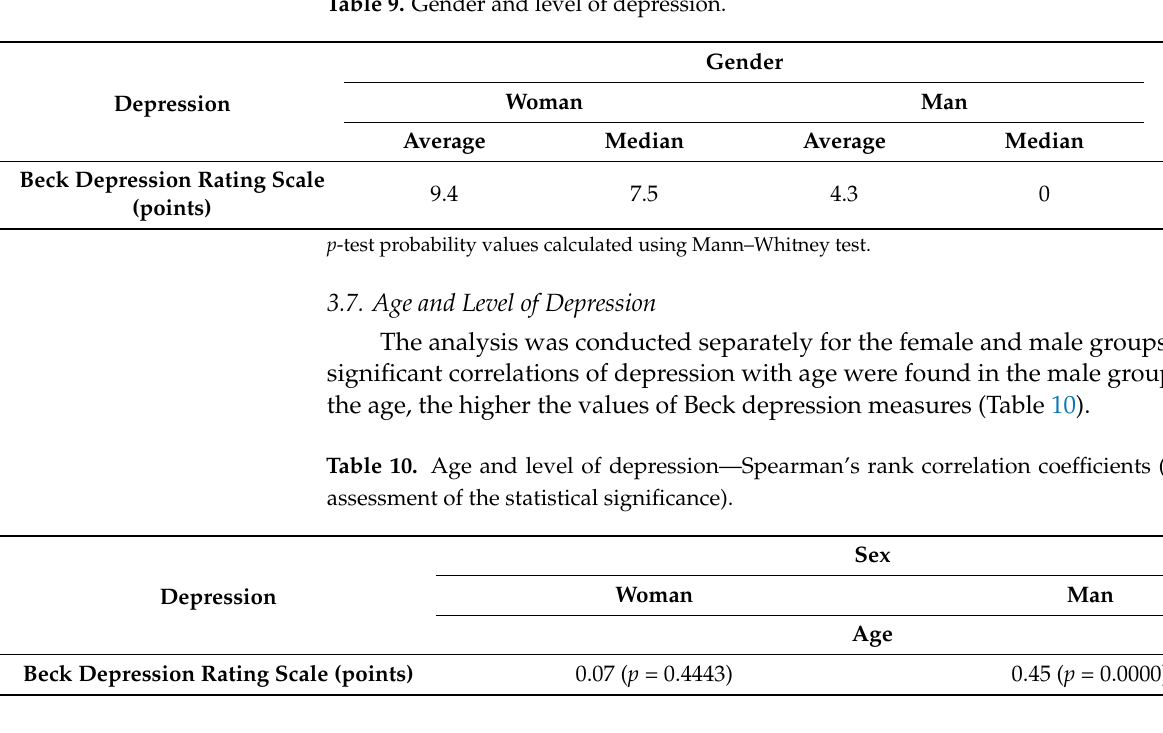
Table 9. Gender and level of depression.